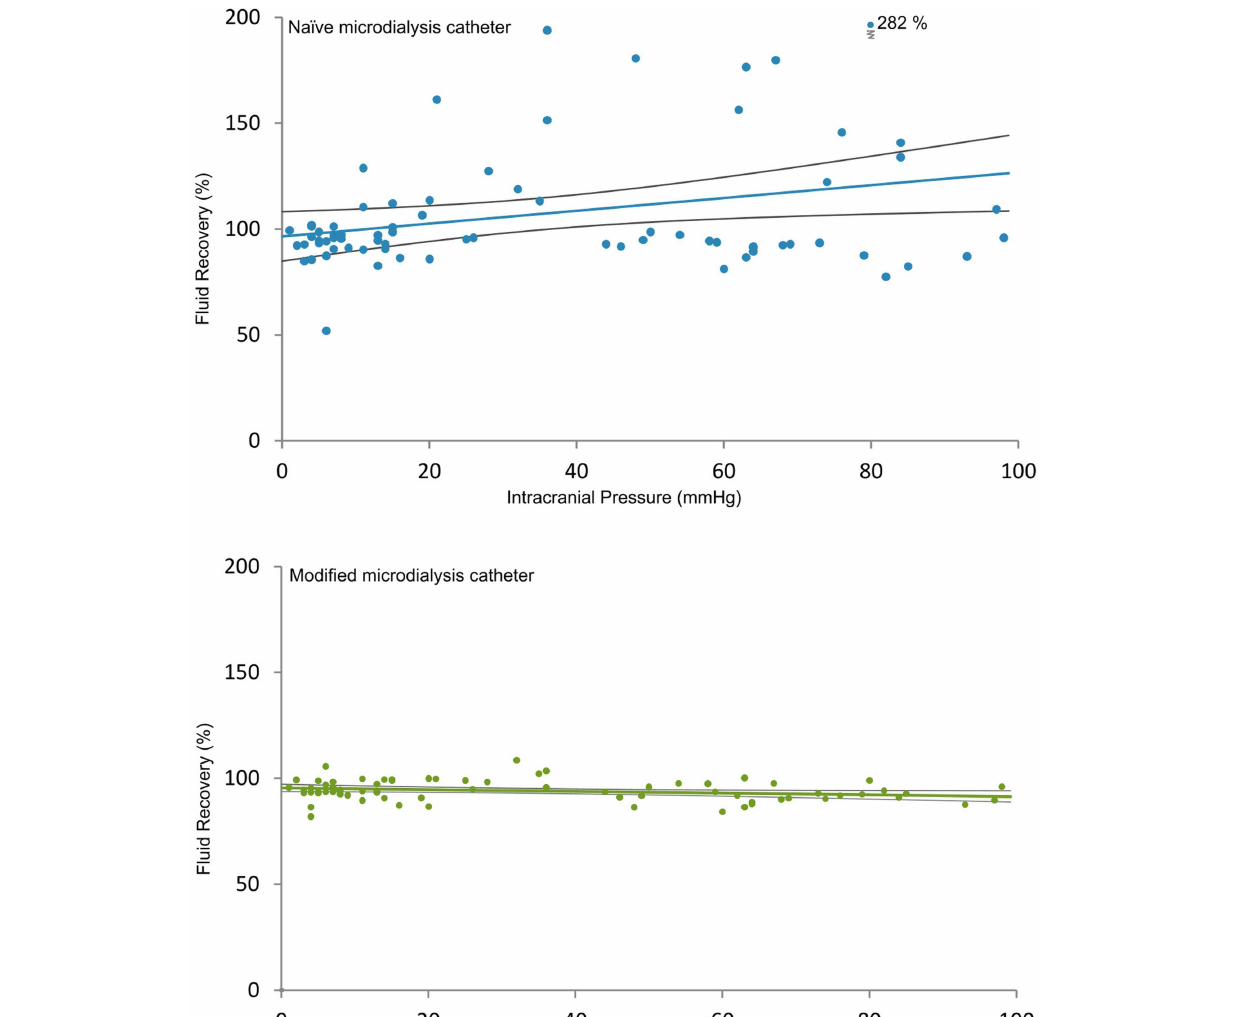
FIGURE 4 | Relation between fluid recovery and ICP for naïve and modified MD catheters is shown .The two diagrams show the relation between FR and ICP for the naïve (upper) and the modified (lower) MD catheters (100kDa Brain Microdialysis Catheter, M Dialysis AB), both perfused (1 µ L/min) with Perfusion Fluid CNS with in-house addition of 3% Dextran 500 (kDa). Each circle is the FR of an individual MD vial plotted against the mean ICP at the end of each corresponding 20-min period. A linear regression line is plotted with 95% confidence interval. Upper panel